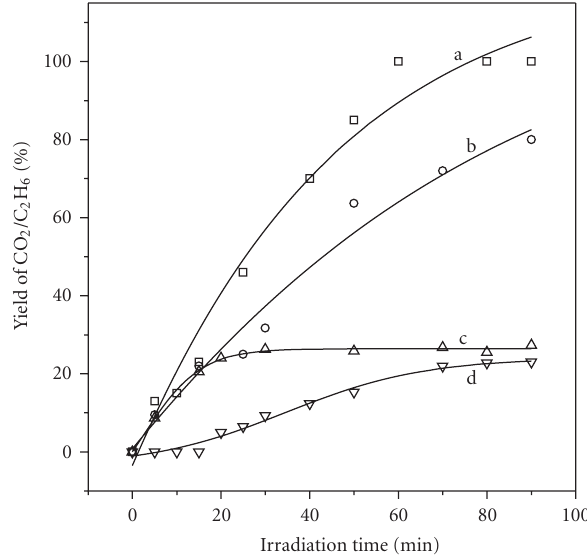
Figure 7: Yield of CO 2 (curves (a)–(c)) and C 2 H 6 (curve (d)) as a function of time, when mesoporous TiO 2 (sample T1) was used for the UV-induced vapor-phase photocatalytic oxidation of ace- tone present at varying concentrations in air. (a) 2.7, (b) 5.3, (c) 10, and (d) 13